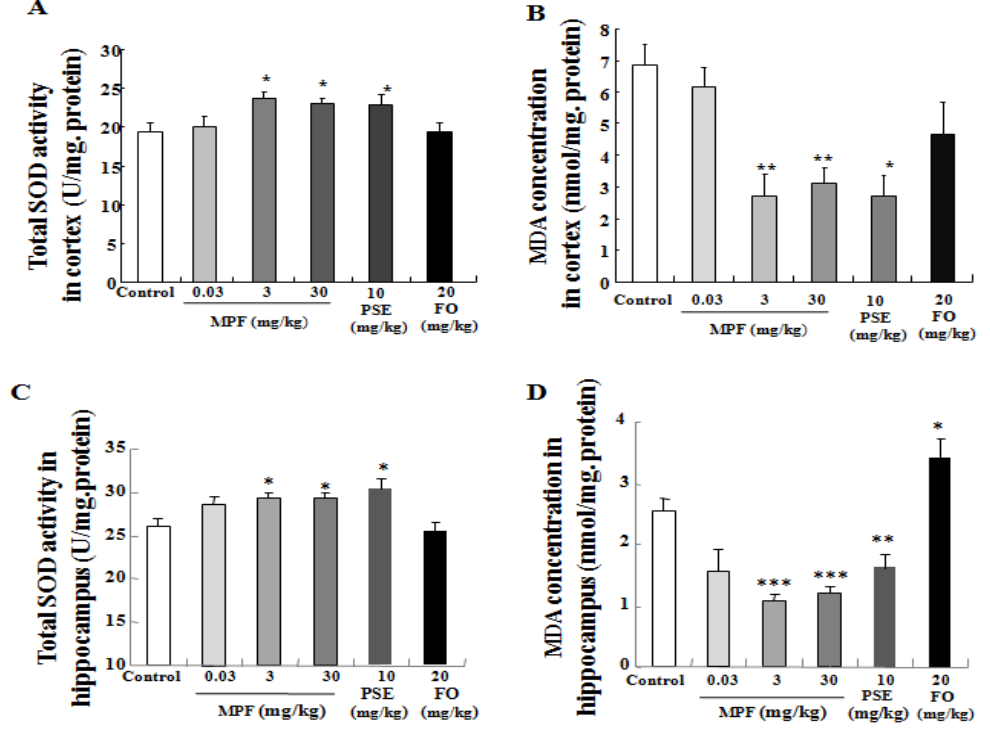
Figure 5. Effects of PSE, FO, and MPF on the SOD activity and MDA level of the cerebral cortex and hippocampus. Effects of PSE, FO, and MPF on the SOD activity and MDA level of the cerebral cortex ( A , B ) and hippocampus ( C , D ) after oral treatment for six weeks. Each value represents the